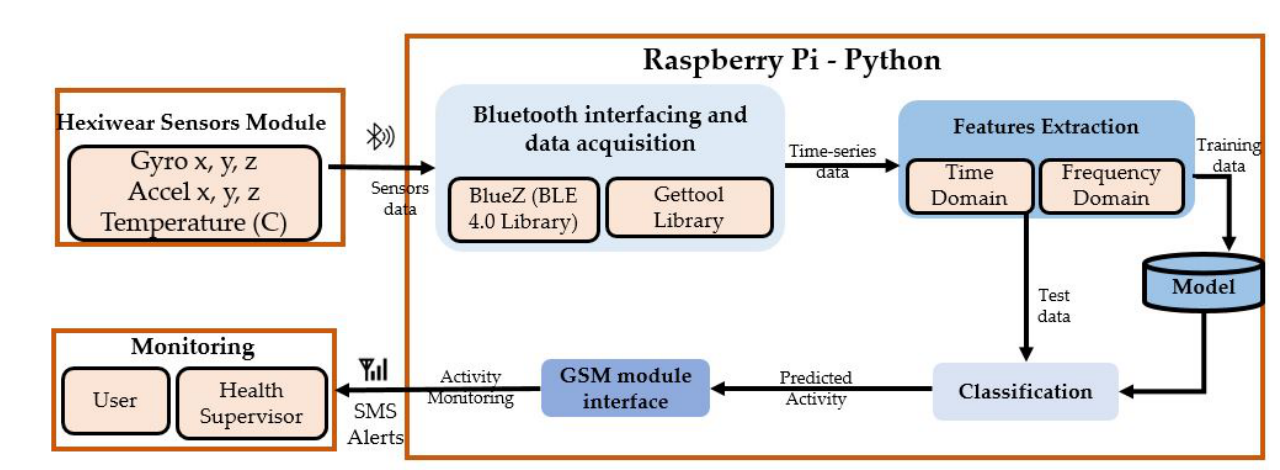
Figure 3. The proposed maternal physical activities recognition system architecture.